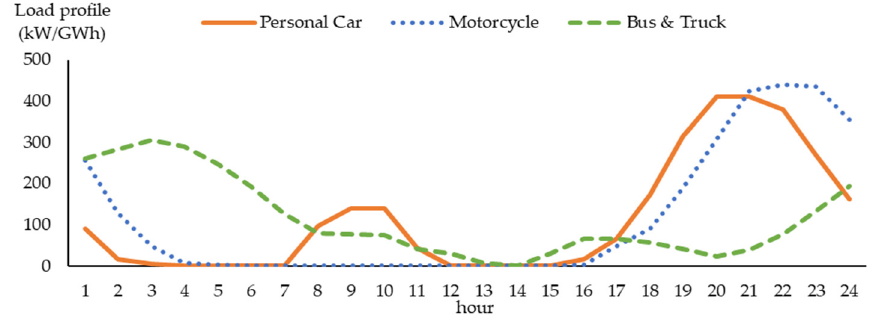
Figure 4. EV charging